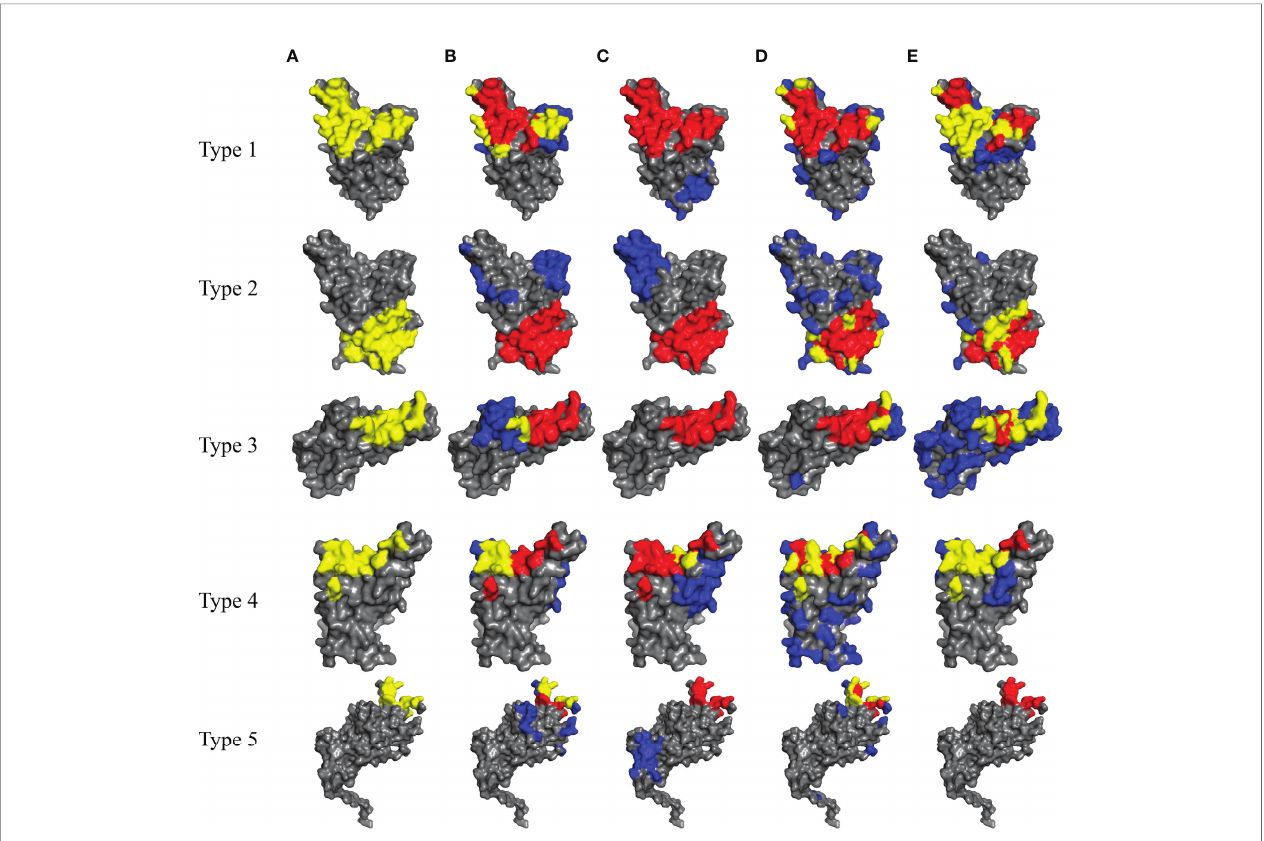
FIGURE 6 | Prediction results for SARS-Cov-2 of fi ve types of BCEs (type 1 to type 5). (A) The true epitope residues. (B – E) Prediction results by Discotope-2.0, EpiPred, PECAN and our method, respectively. TP predictions are in yellow, FN predictions are in red, FP predictions are in blue and the background grey represents TN